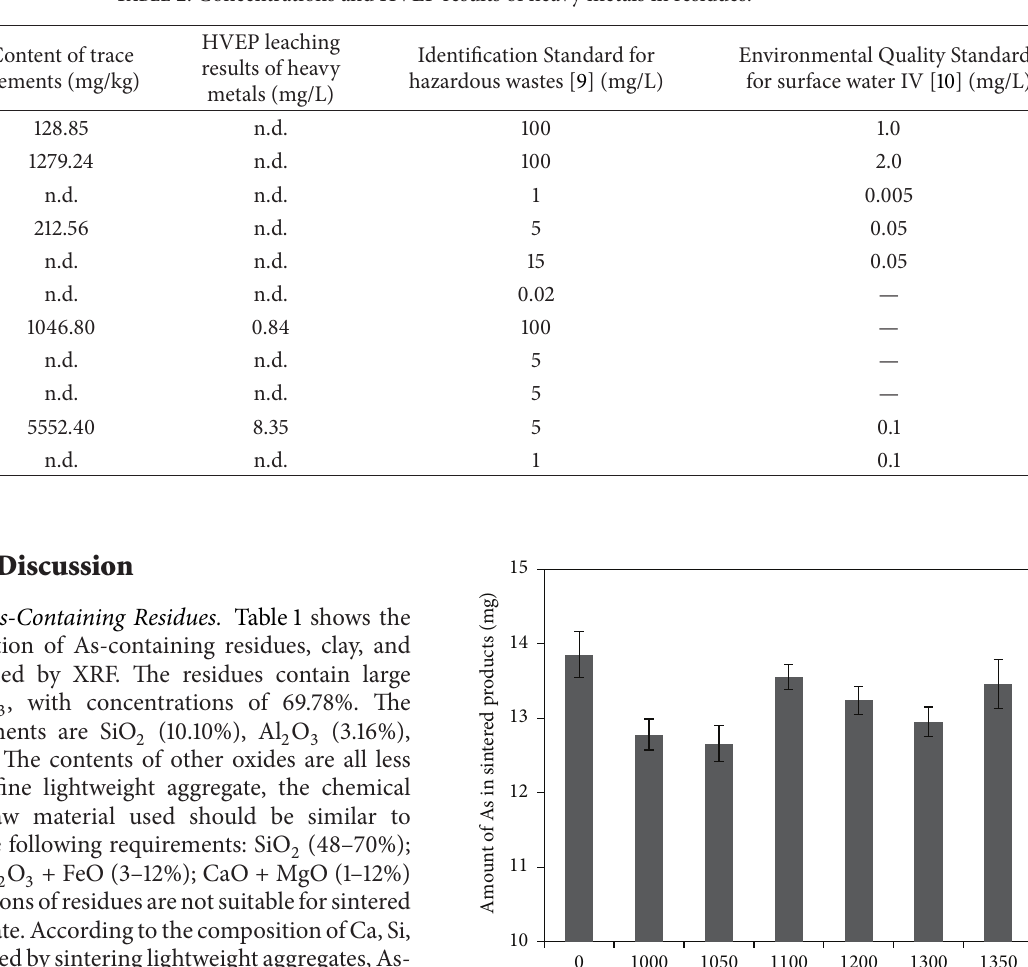
Table 2: Concentrations and HVEP results of heavy metals in residues.